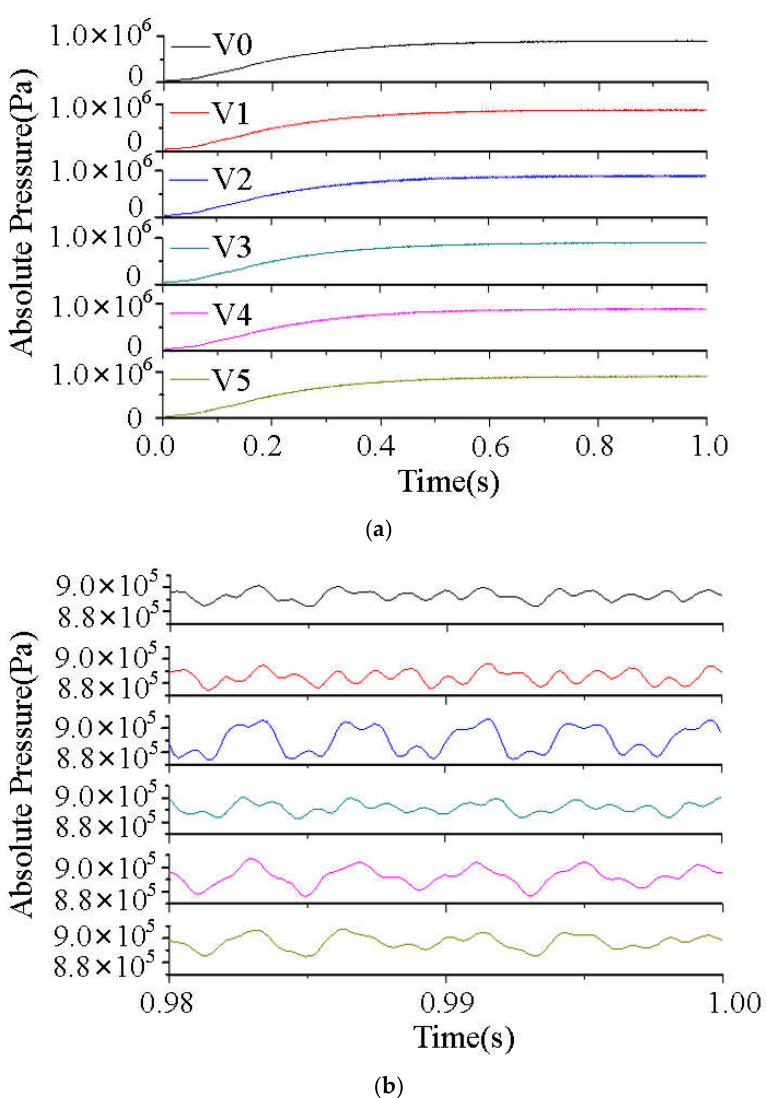
Figure 21. Development of pressure at the volute: ( a ) the focused view and ( b ) the enlarged view.